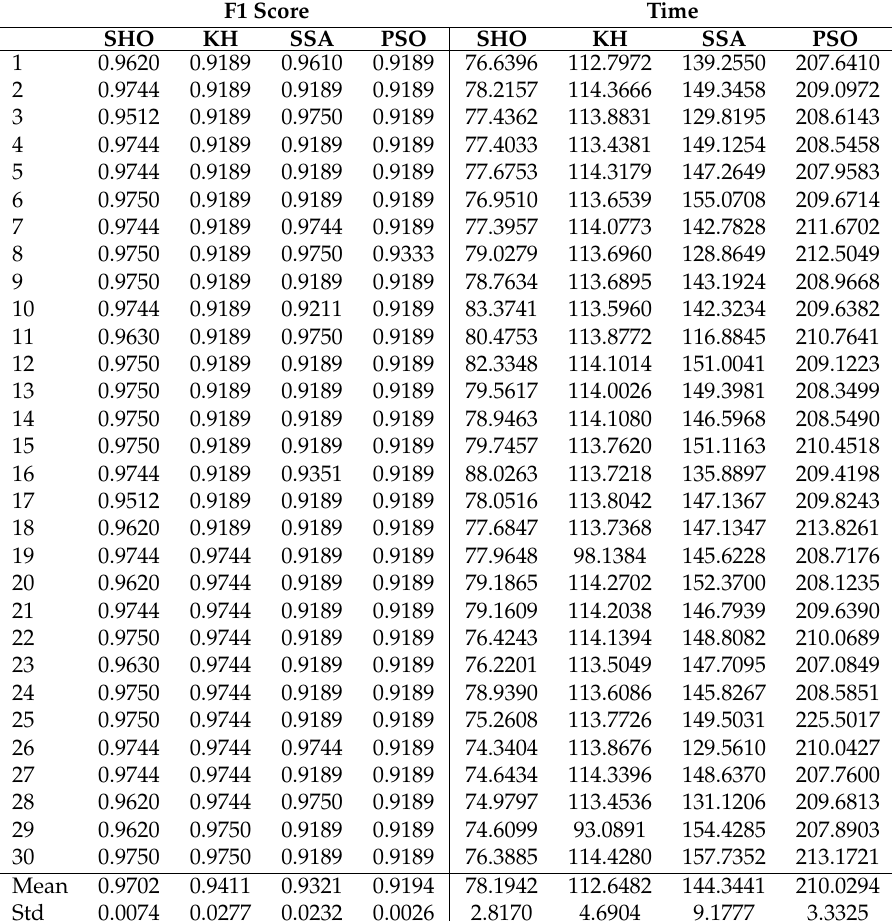
Table 3. F1 score—Times.